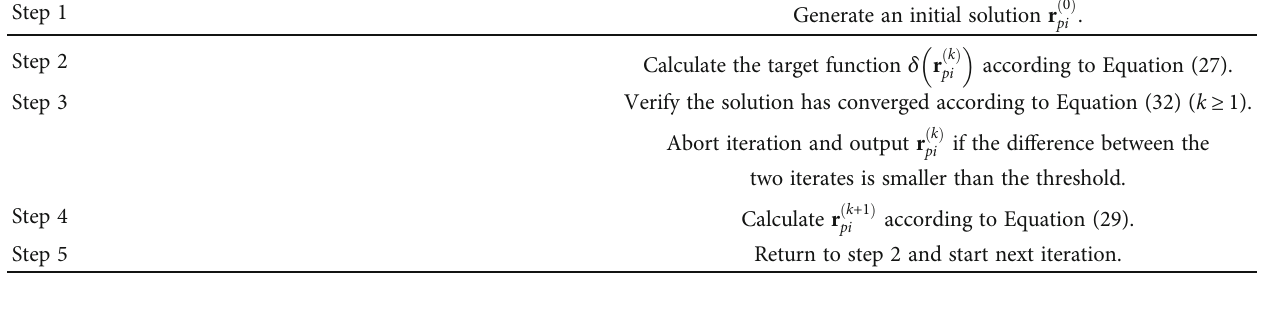
Table 1: Initial position solution process using Newton-Raphson